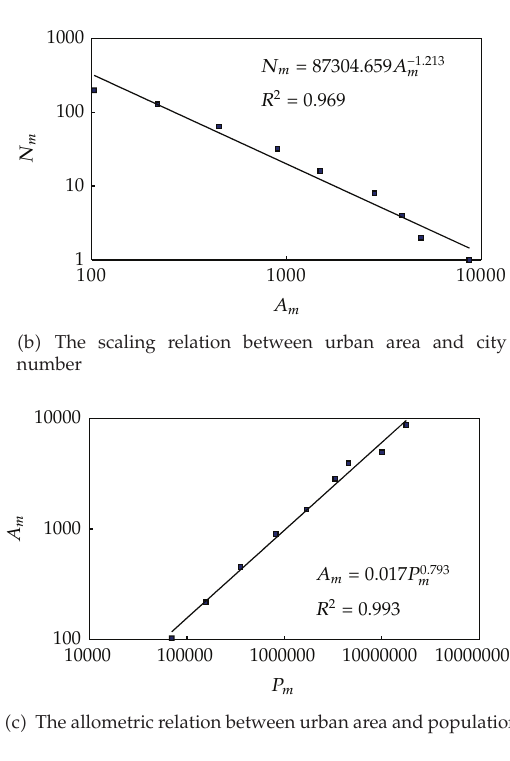
Figure 2: The scaling patterns for the hierarchy of the 452 cities in America (cid:6) 2000 (cid:7)